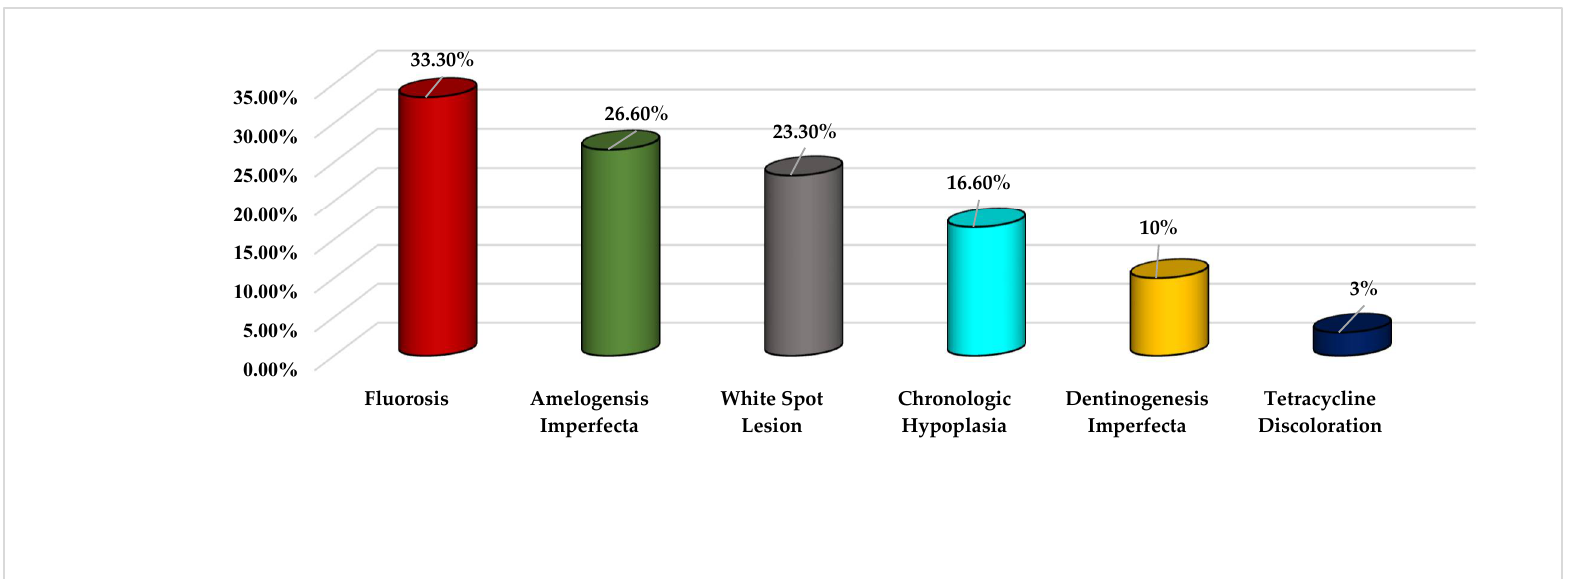
Figure 1. Participants’ choices for alternative diagnoses of MIH cases.